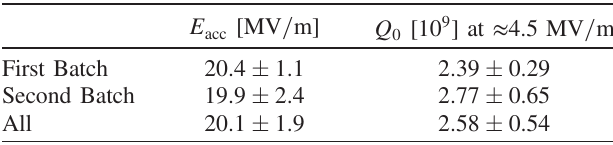
TABLE VIII. Summary of EXFEL 3.9 GHz vertical test performances. The uncertainties are the standard deviations of the measured values.